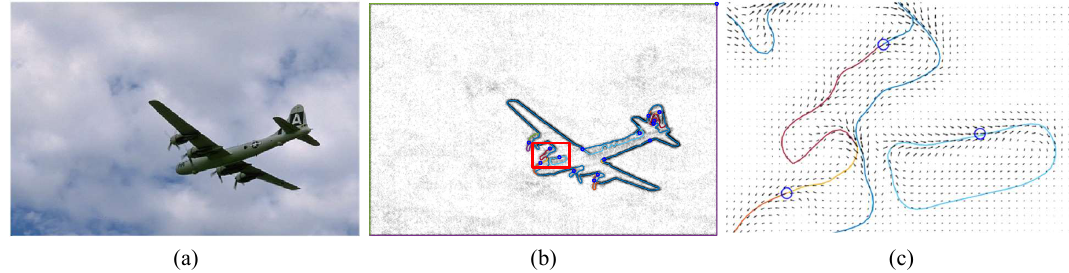
Figure 8. ( a ) BSDS500 #3096, ( b ) particle trajectory obtained from Equation (3), and ( c ) zoom of ( b